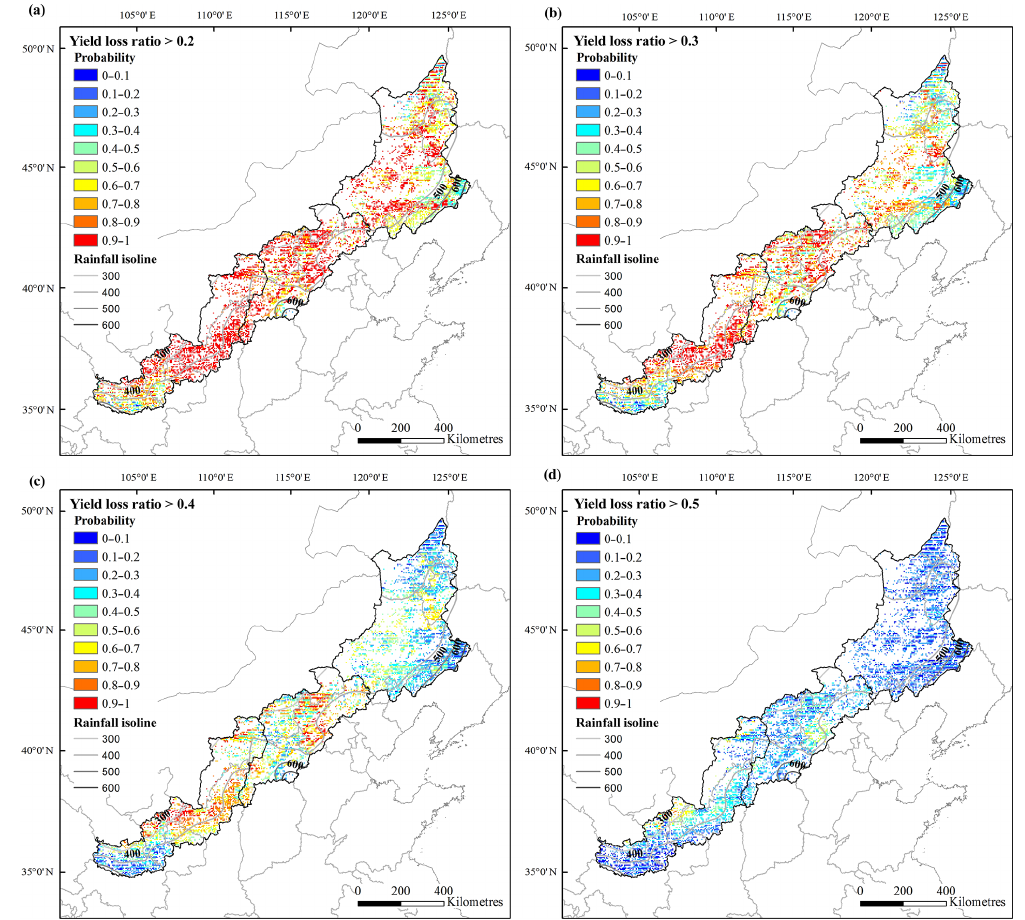
Figure 12. Probability distribution of spring maize yield loss ratio for different yield loss levels. (a) Yield loss ratio ≥ 0.2, (b) yield loss ratio ≥ 0.3, (c) Yield loss ratio ≥ 0.4, (d) yield loss ratio ≥